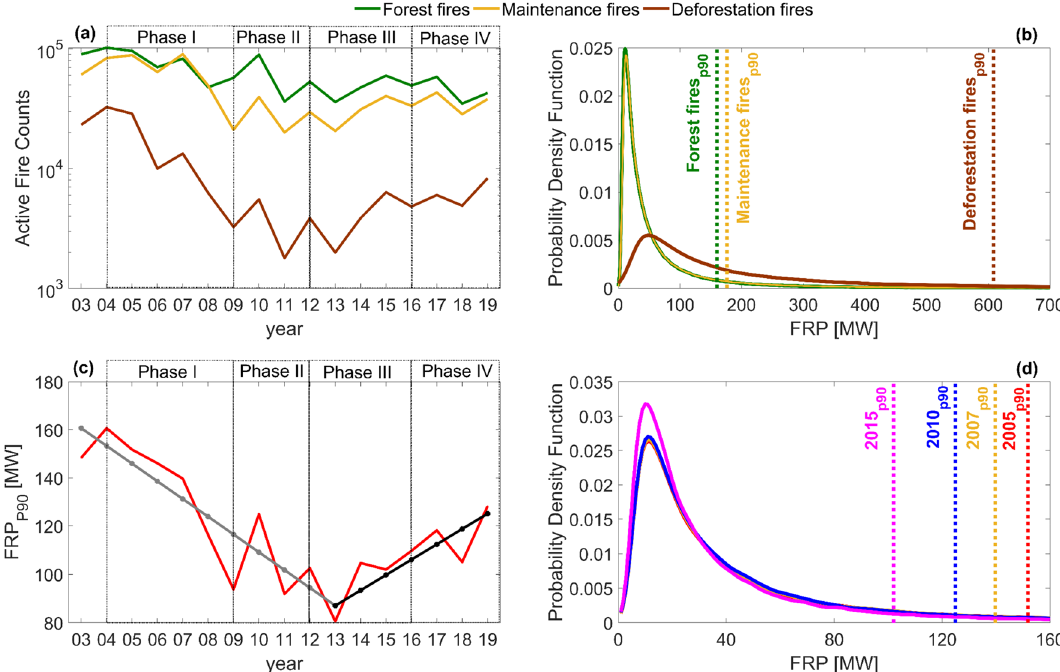
Figure 3. ( a ) Interannual variability of active fires classified as forest fires (green), maintenance fires (orange), and deforestation fires (brown) for the BAMZ; ( b ) Probability density function of FRP for each fire type from 2003 to 2019; ( c ) Interannual variability of the 90th percentile of FRP and the linear regression model with a break point representing the best minimum square fit of all models (with break points between 2005 and 2017). Trend significance was analyzed with a two-tailed Mann–Kendall test of significance at the 0.05 level, and both the decreasing (2003–2013) and the increasing (2013–2019) branches are significant; ( d ) Probability density function of fire radiative power (FRP) for drought years 2005, 2007, 2010, and 2015. Vertical lines indicate the 90th percentile of FRP for each ( b ) fire type; ( d )